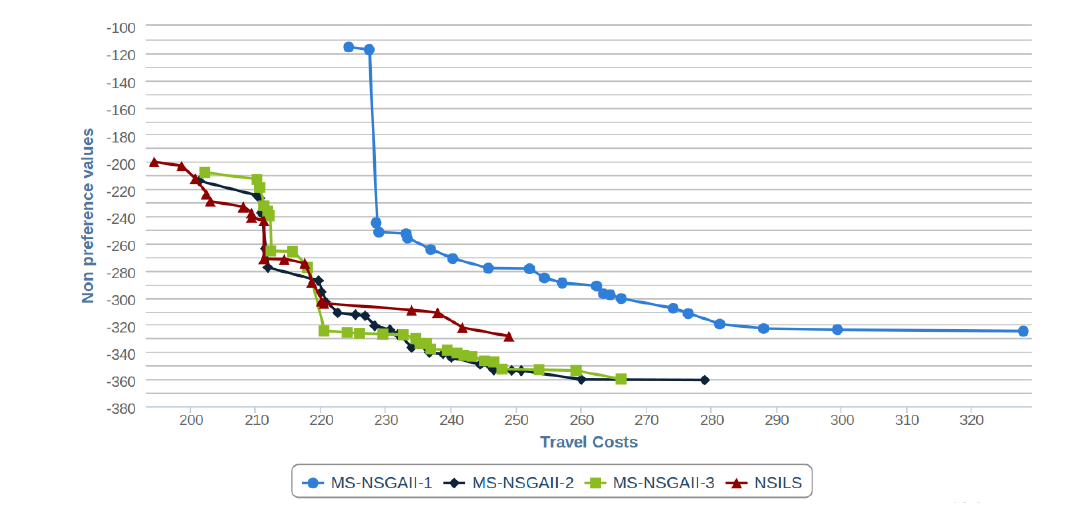
Figure 7. Impact of local search for Instance 25 on MS-NSGAII